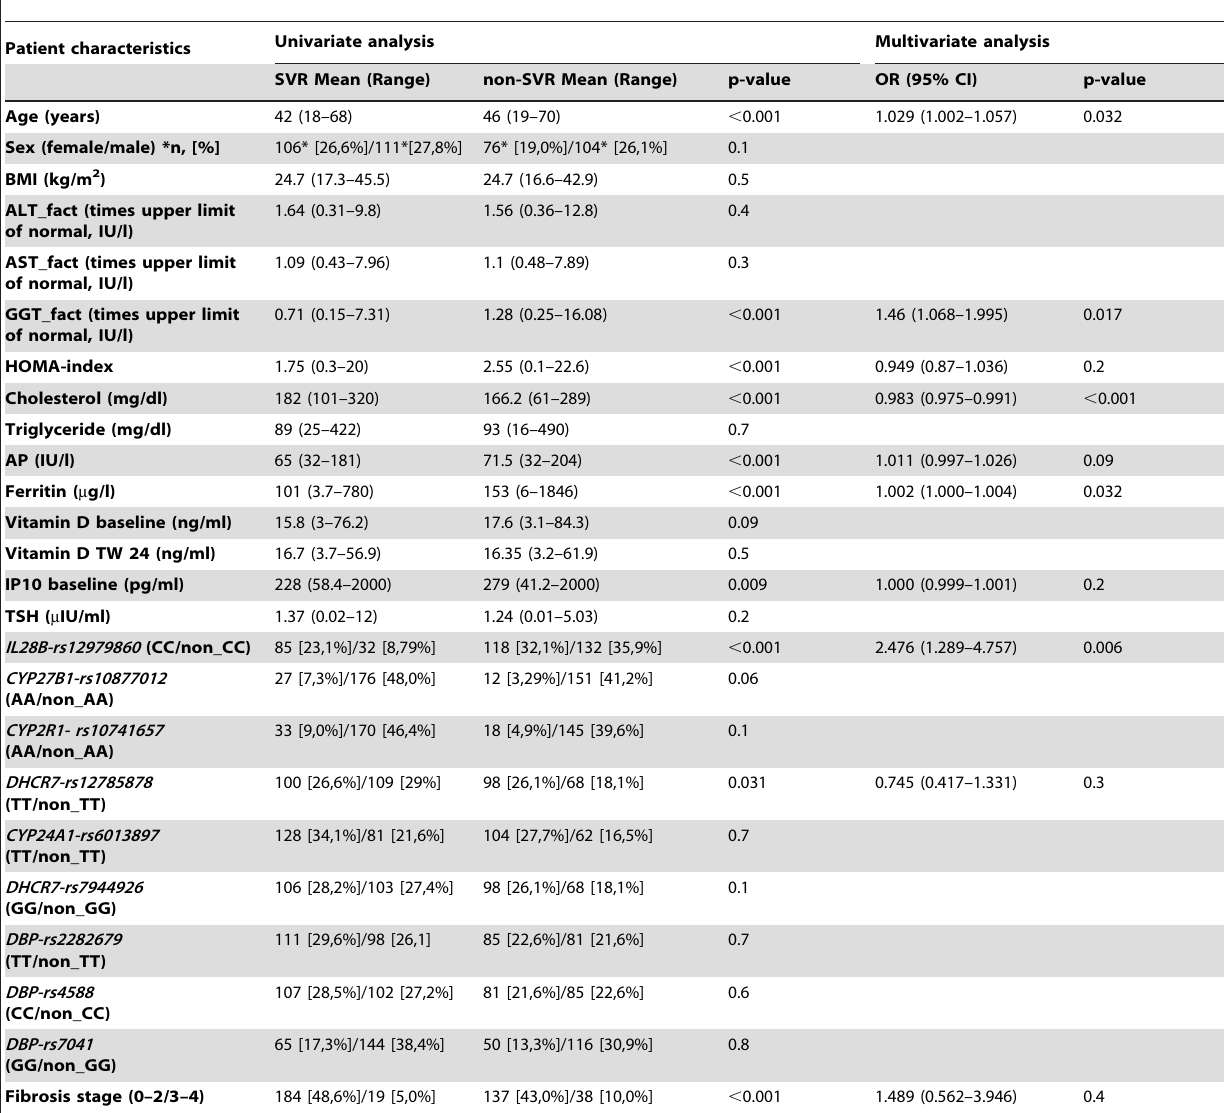
Table 2. Uni- and multivariate analysis of predictors of SVR to antiviral